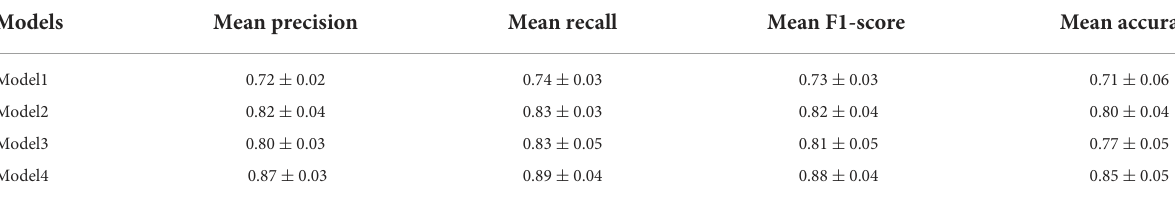
TABLE 3 Ablation experiment with difference maps and CNN